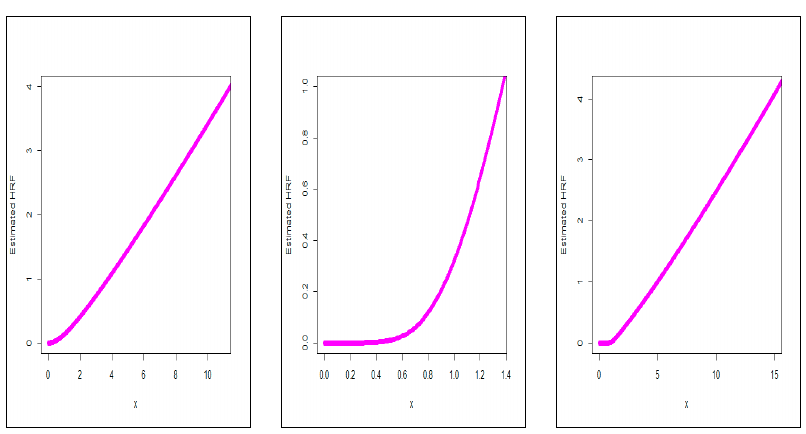
Figure 5. Estimated HRFs.